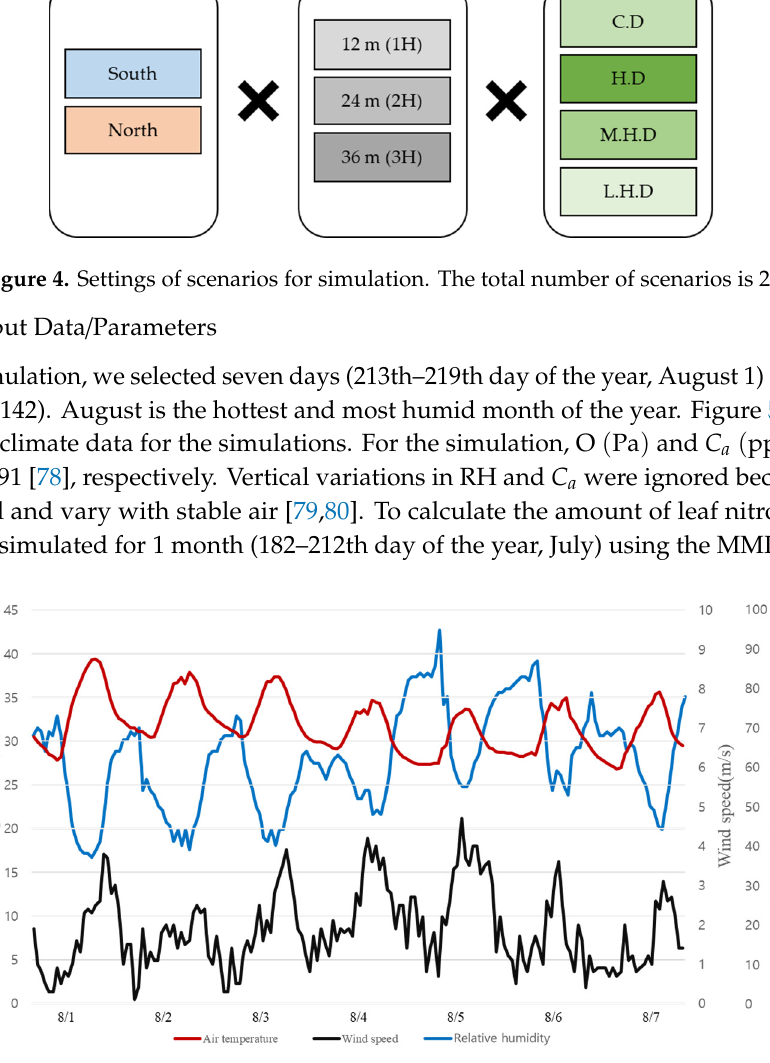
Figure 5. Meteorological data for the model simulation.